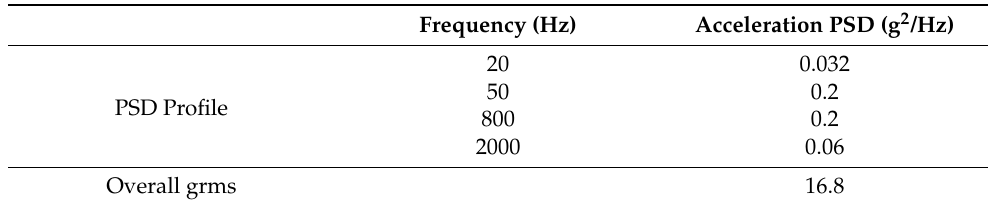
Table 3. Qualification random vibration load case. (Duration is 2 min).